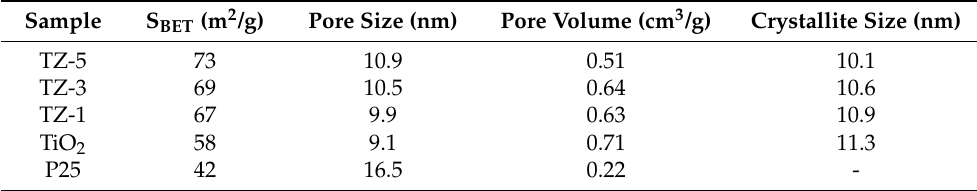
Table 1. Physicochemical properties of TiO 2 , TZ-1, TZ-3 and TZ-5